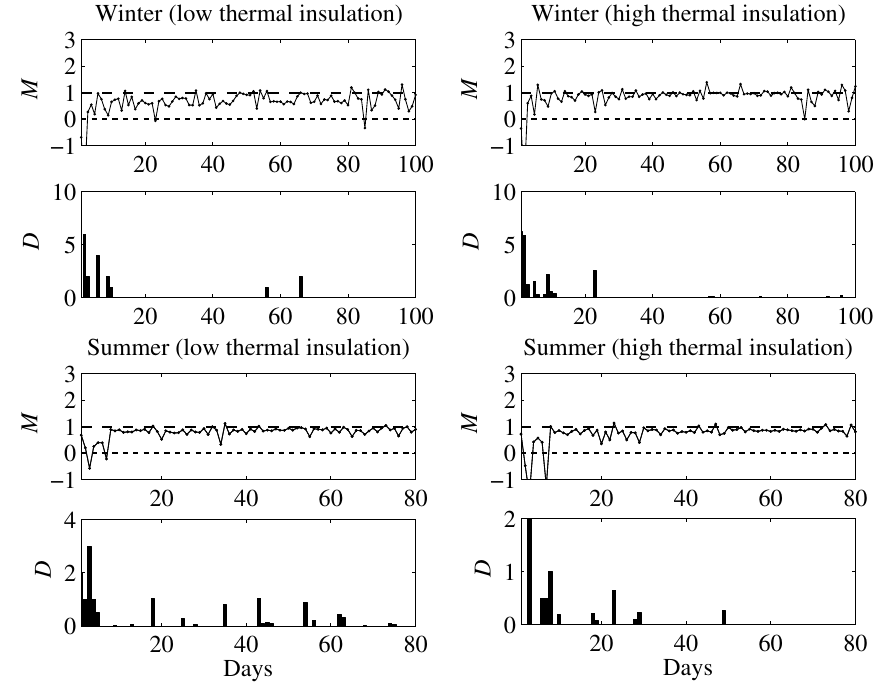
Figure 5. The performance metric M and the temperature violations D for the learning agent with a set-back